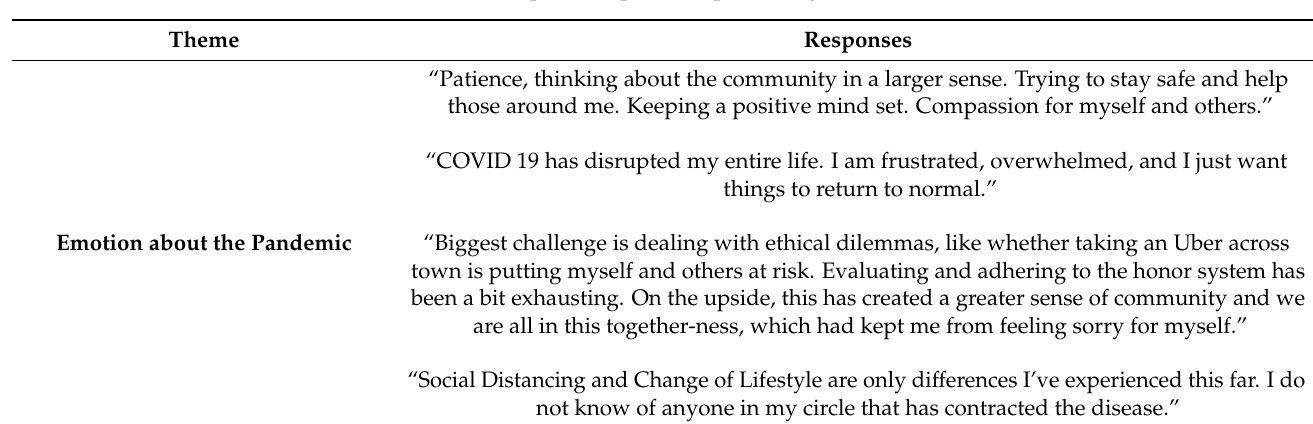
Table 2. Example of responses representing each